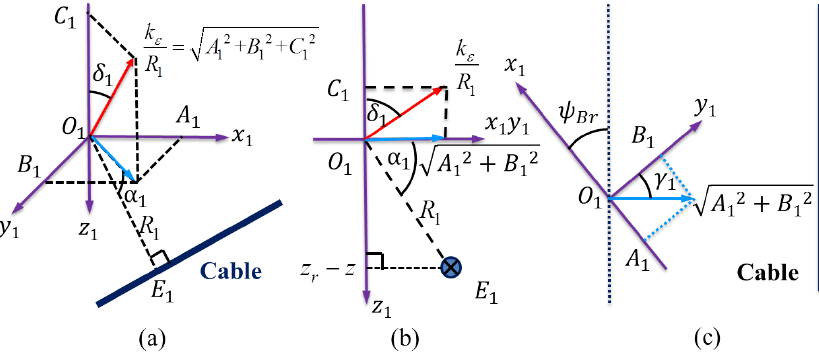
Figure 6. ( a ) Three-dimensional view of the magnetic sensing; ( b ) Two-dimensional vertical view; and ( c ) Two-dimensional horizontal view. There are (cid:113) ) , A = + B 2 A 2 arcsin ( z r − z sin ( γ 1 ) with γ 1 = ψ Br = ψ B − ψ r , B 1 = 1 R 1 1 1 C 1